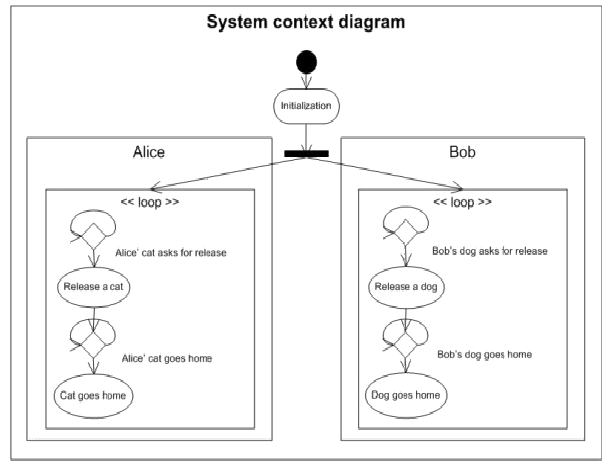
Figure 10. Example of an IOD used for orchestrating a set of use